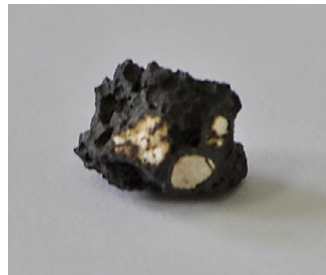
Figure 1. Free lime in the slag at the end of oxygen blowing in the melting process B, sample